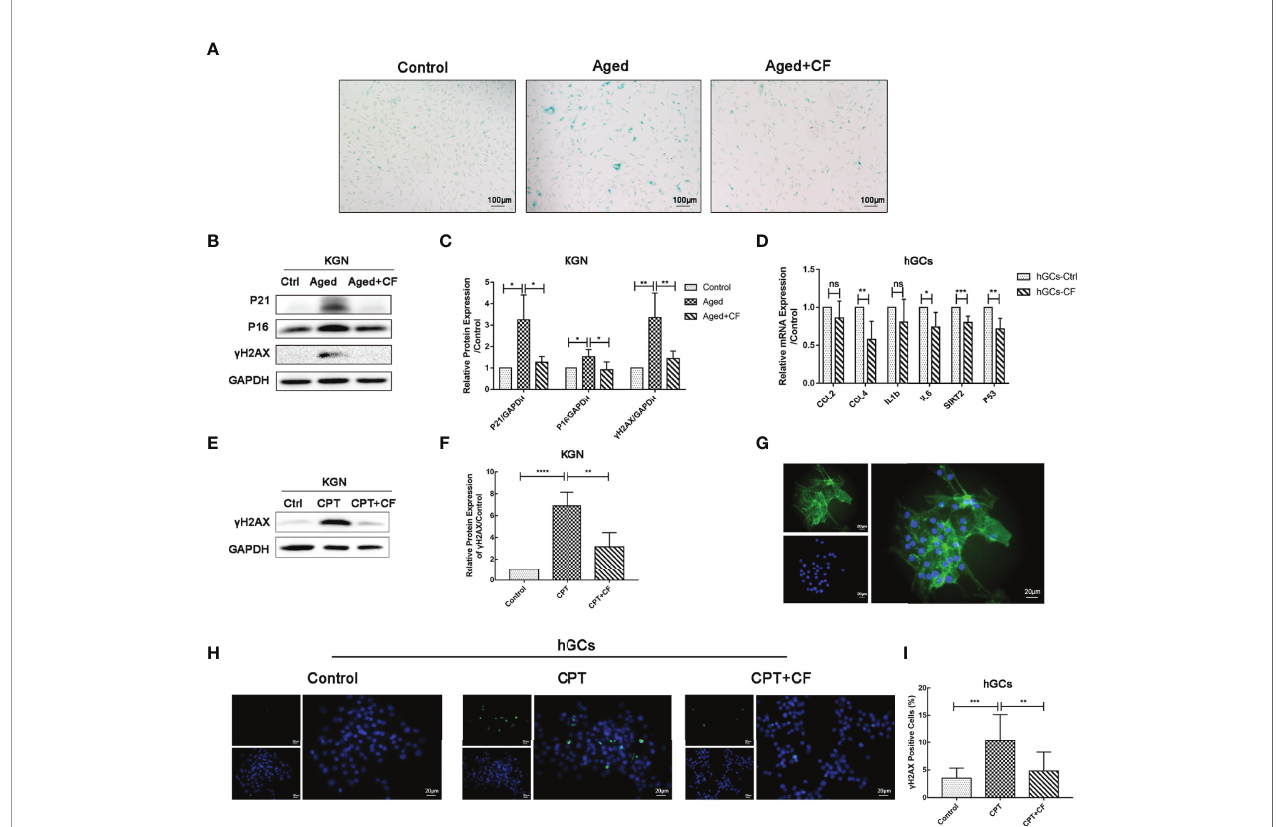
FIGURE 6 | CEFFE resists DNA damage and alleviates the senescence of KGN cells and hGCs. (A) Representative images of SA- b -gal staining. Scale bar=100 m m. (B) The senescent markers P21 and P16 and DNA damage marker g H2AX were detected via Western Blotting. (C) The protein expression of P16, P21, and g H2AX was analyzed. (D) qRT-PCR analysis of age-related gene expression in hGCs. (E) After being exposed to CPT and following treatment with/without CEFFE, g H2AX was detected via Western Blotting in KGN cells. (F) The protein expression of g H2AX was analyzed in KGN cells. (G) hGCs were identi fi ed using FSHR protein, which was speci fi cally located in the cytoplasm of hGCs. FSHR was labeled with green fl uorescence, and the nucleus was labeled with blue fl uorescence. Scale bar=20 m m. (H) The DNA damaged marker g H2AX was detected in hGCs induced by CPT with the immuno fl uorescence method. g H2AX was labeled with green fl uorescence, and the nucleus was labeled with blue fl uorescence. Scale bar=20 m m. (I) Statistics of g H2AX-positive hGCs. CPT, camptothecin. Three independent experiments were conducted in each group, and data are represented as the mean ± SD, ns: P > 0.05, * P < 0.05, ** P < 0.01, *** P < 0.001, and **** P <